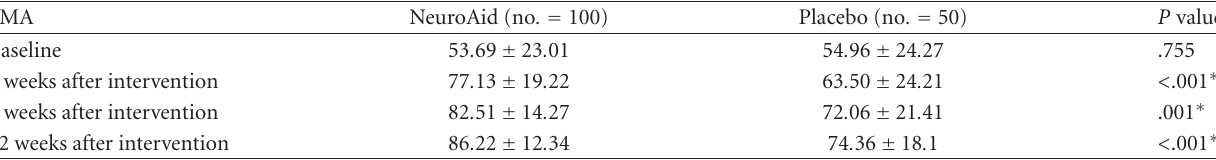
Table 2: Fugl-Meyer Assessment score at baseline and after treatment in the NeuroAid and the placebo group.